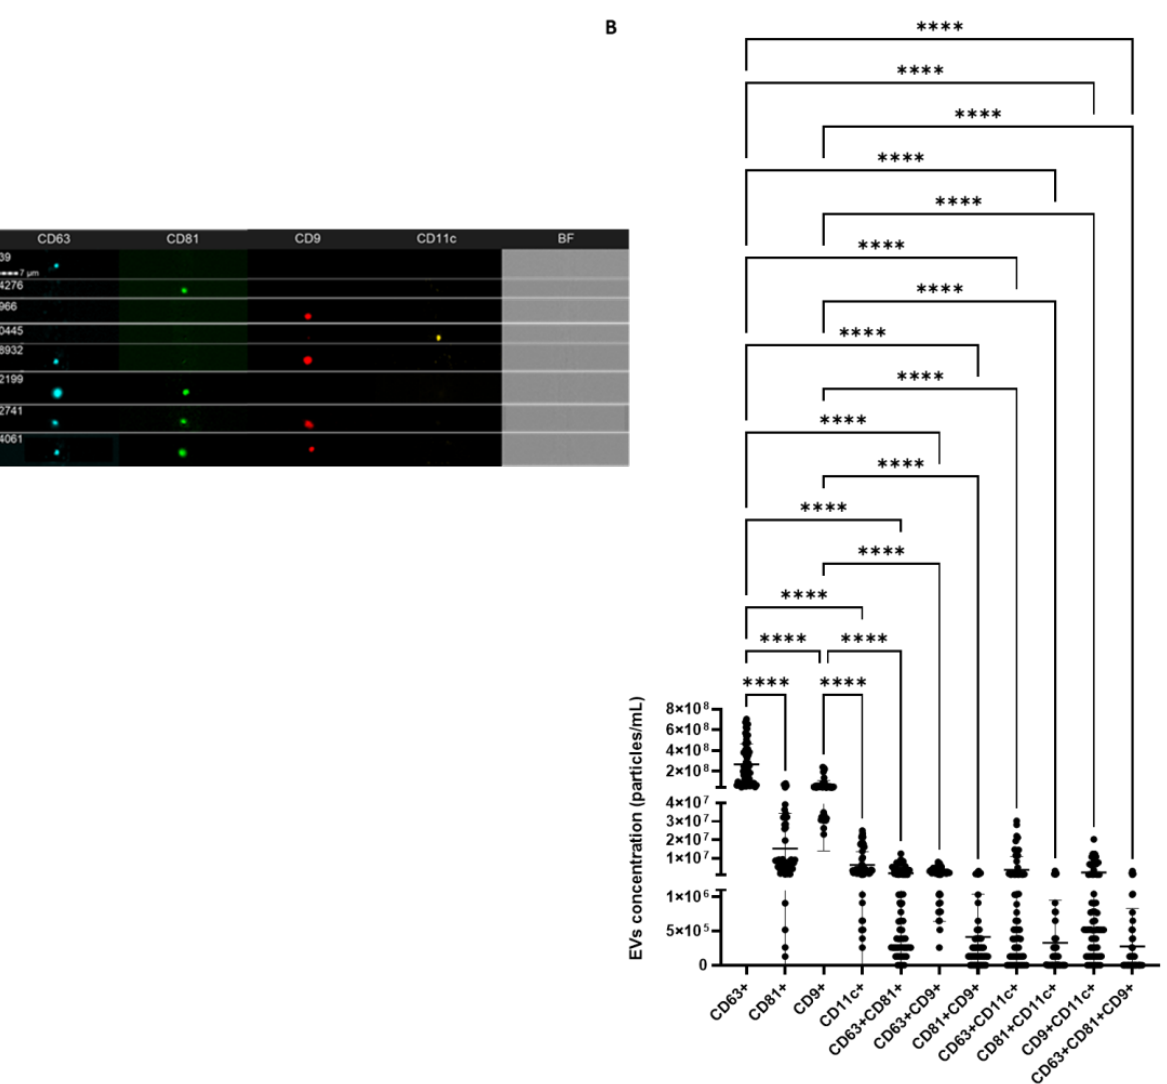
Figure 3. ( A ) shows representative captured particles with a positive signal to the tetraspanins CD63, CD81, CD9, and the integrin CD11c. ( B ) Graphs reporting the EV concentration (mean ± SD) of single- double- and triple- positive EVs to the surface markers (n = 60). BF: Brightfield; **** p < 0.0001.